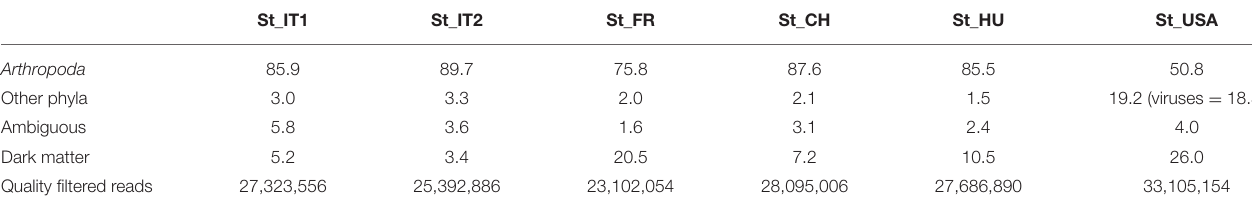
TABLE 1 | Percentages of the host ( Arthropoda ), non-host (other phyla), ambiguous, and unknown (dark matter) reads in each